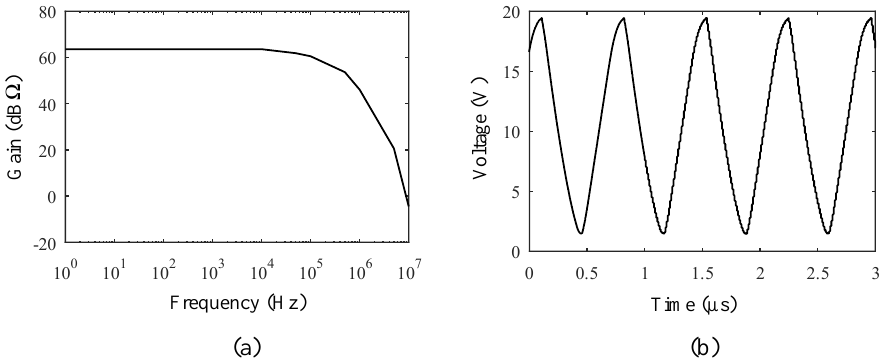
Figure 9. Measurement results: ( a ) Frequency domain measurements of the RGC TIA, ( b ) Time domain measurements of the high-voltage